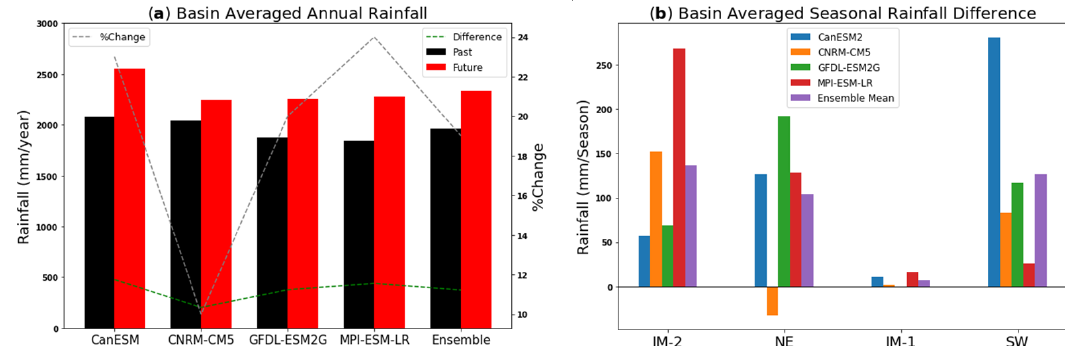
Figure 4. ( a ) The comparison of basin average annual rainfall (mm/year) between past and future climate and percentage changes (%) for each selected GCM; and ( b ) basin average seasonal rainfall differences (future—past) for selected GCMs and the ensemble mean.